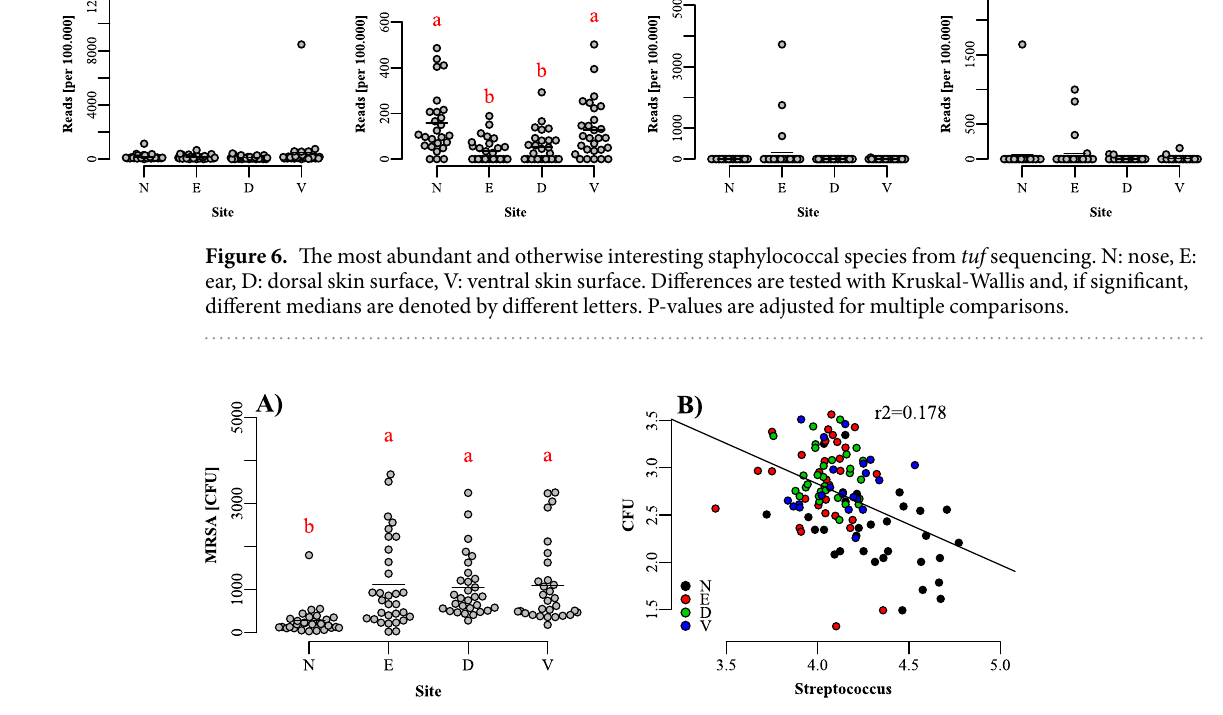
Figure 7. ( A ) MRSA counts by plating and the association to Streptococcus by V1-V2 sequencing. ( B ) Correlations of Streptococcus and MRSA CFU. N: nose, E: ear, D: dorsal skin surface, V: ventral skin surface. Differences are tested with Kruskal-Wallis and, if significant, different medians are denoted by different